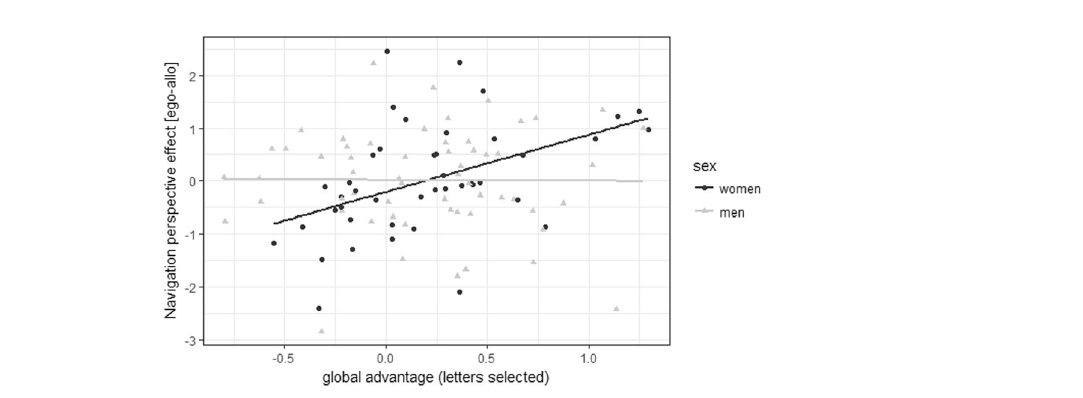
Figure 1. Effects of sex, material and attention condition on the global advantage effect (GA). GA was significantly larger in the selected compared to the divided attention condition and with letter stimuli compared to shape stimuli. Sex and menstrual cycle phase did not affect the GA effect.